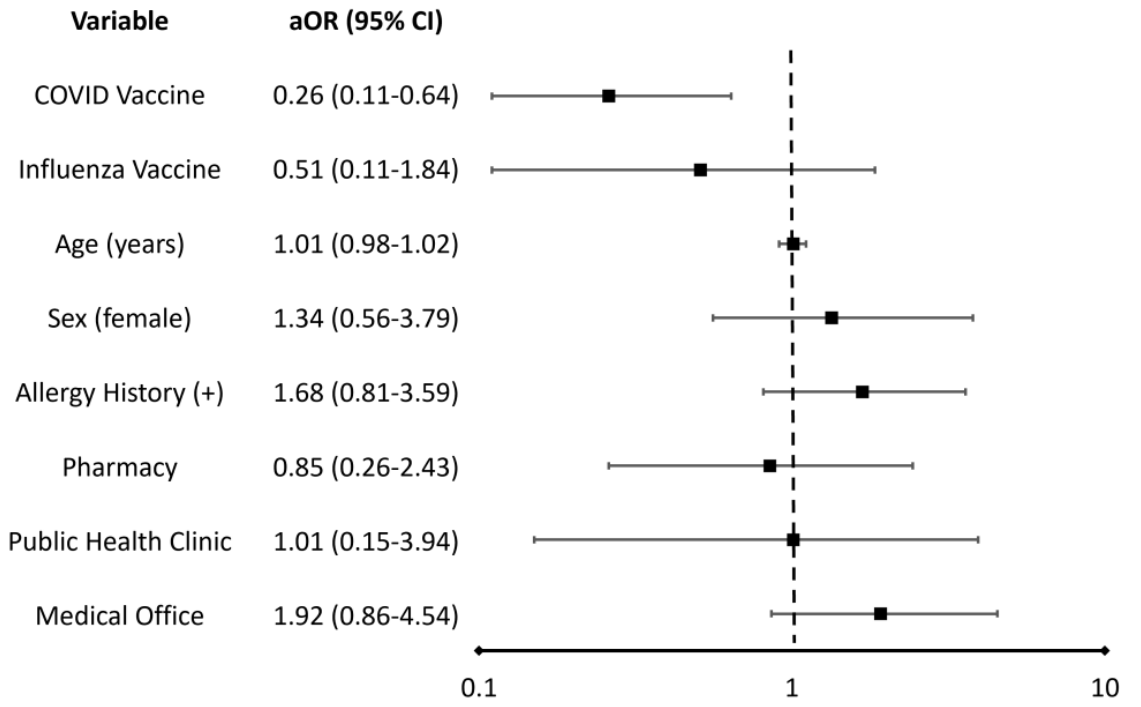
Figure 2. Adjusted odds ratios (aOR) and 95% confidence intervals (CI) of death and disability associated with reports of post-vaccination anaphylaxis for each regression variable *. When holding other covariates constant in the regression analysis, an odds ratio greater than 1 indicates that the outcome of death and disability is more likely to occur when the variable is present. Conversely, an odds ratio less than 1 indicates that the outcome is less likely to occur when the variable is present.